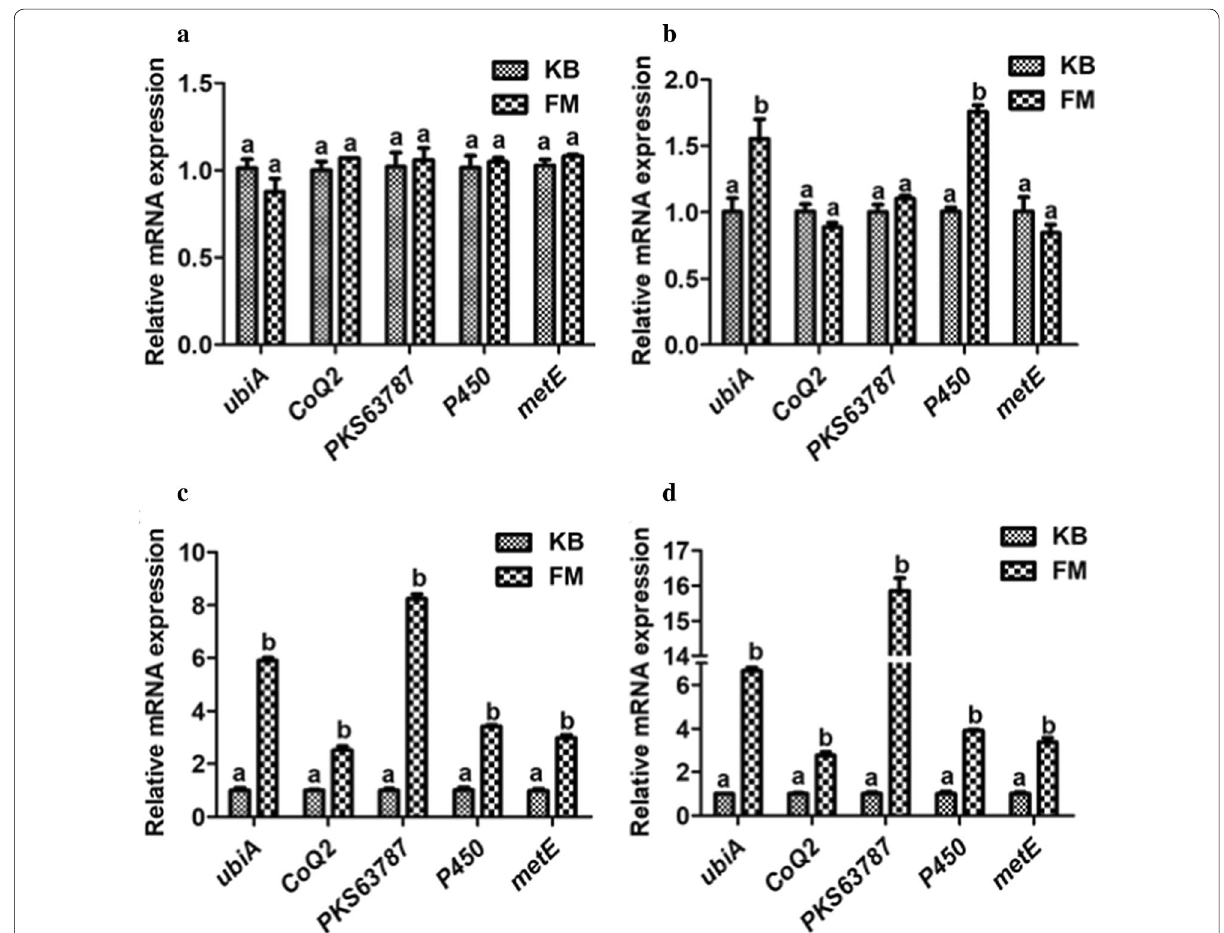
Fig. 7 The q-PCR analysis of mRNA expression of genes potentially related to the biosynthesis of AQ on days 4 ( a ), 5 ( b ), 8 ( c ), and 10 ( d ). Means with different letters differed significantly ( P < 0.05). The experiments were carried out with three biological repeats. Values are given as the means standard deviations (n ± =